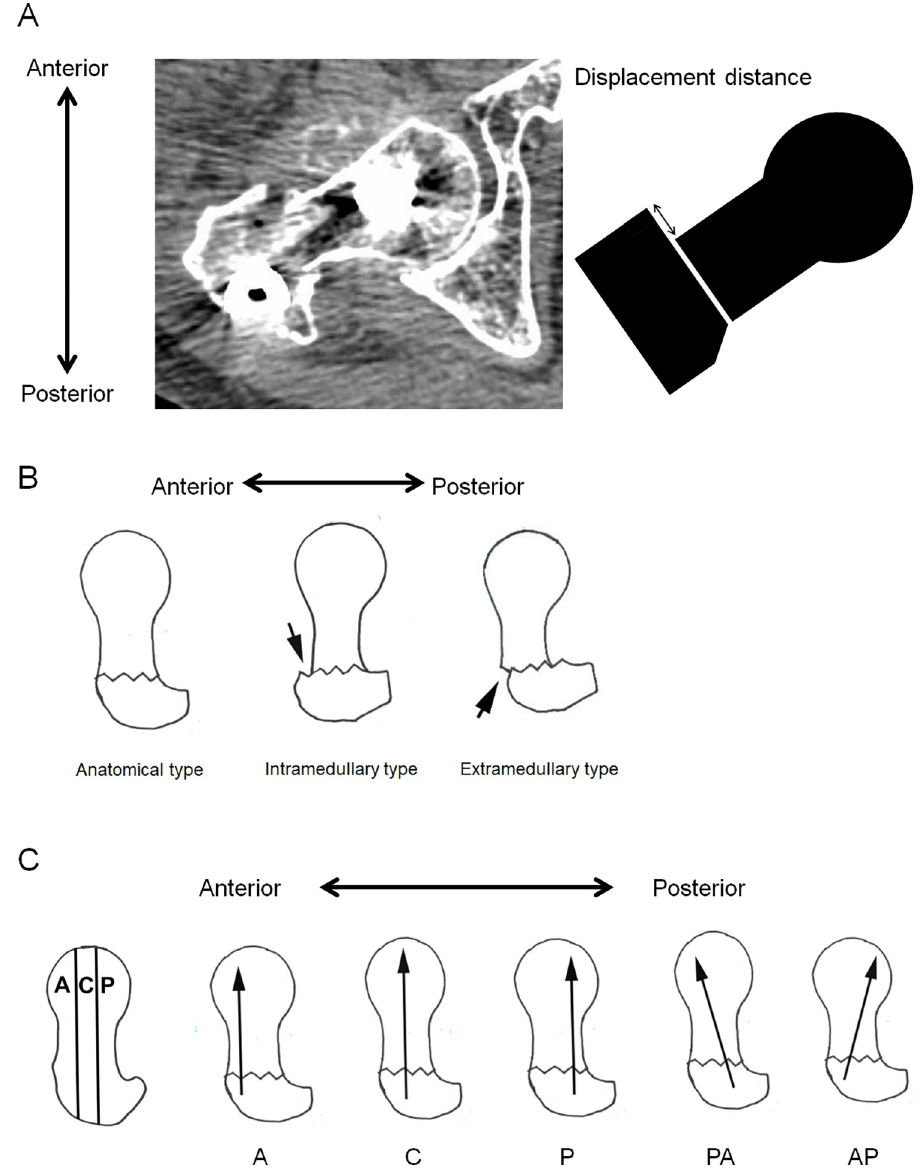
Fig 2. Computed tomography indices. (A) Displacement distance. The displacement distance of the proximal fragment relative to the distal fragment was measured at the anterior wall of the fracture site. (B) Reduction status. The reduction status was classified as “anatomical type” when there was no displacement of the anterior walls of the fragments, and as “intramedullary type” or “extramedullary type” when the anterior wall of the proximal fragment was displaced posteriorly or anteriorly relative to the anterior wall of the distal fragment, respectively. (C) Screw direction. The screw direction was categorized according to the insertion and tip of the lag screw. When the insertion and tip of a screw were placed in the same area, the screw direction was considered have no deviation, and was categorized according to its position (A: Anterior; C: Central; P: Posterior). The screw direction was considered to show deviation when the insertion and tip were placed in different areas and was categorized as AP (from anterior to posterior) or PA (from posterior to anterior) according to the direction.